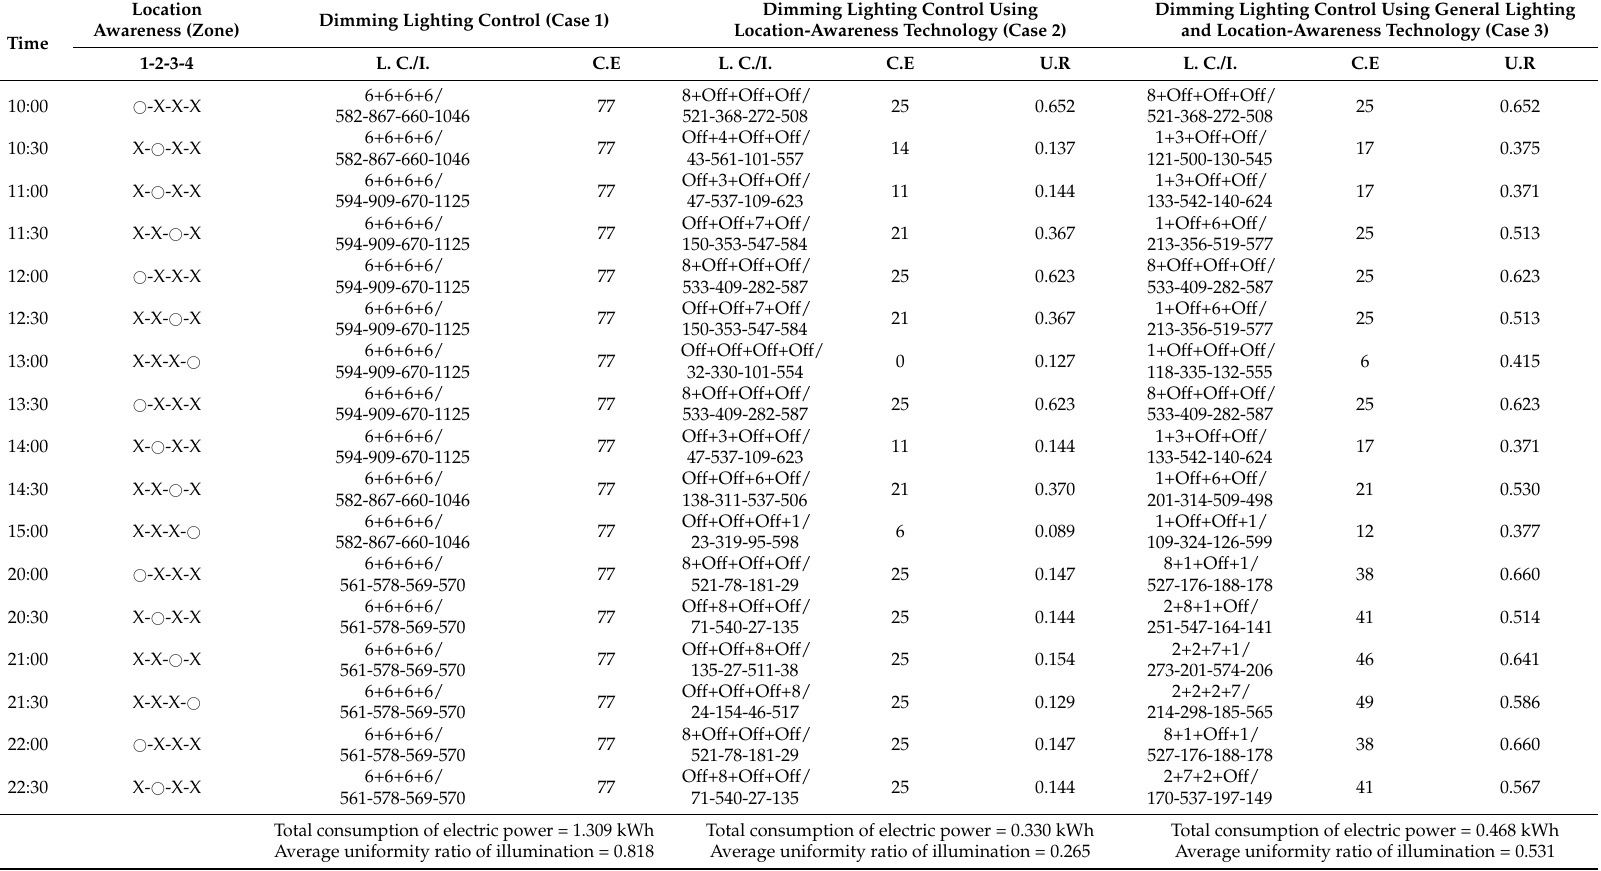
Table 9. Performance evaluation results based on one occupant.